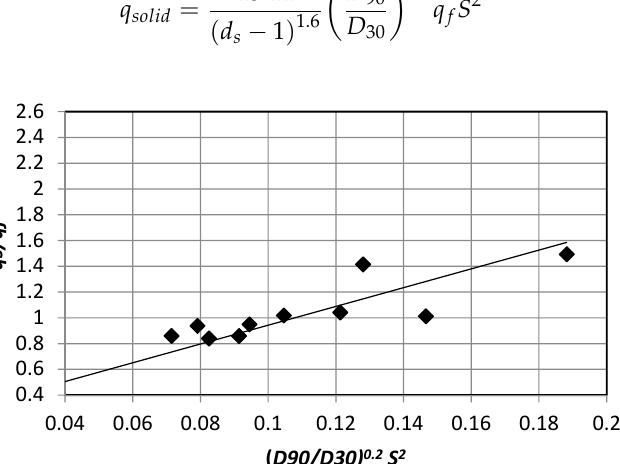
Figure 8. Calibration of Rickenmann’s bedload equation for steeper slopes in our flume tests between 14 and 20 degrees.